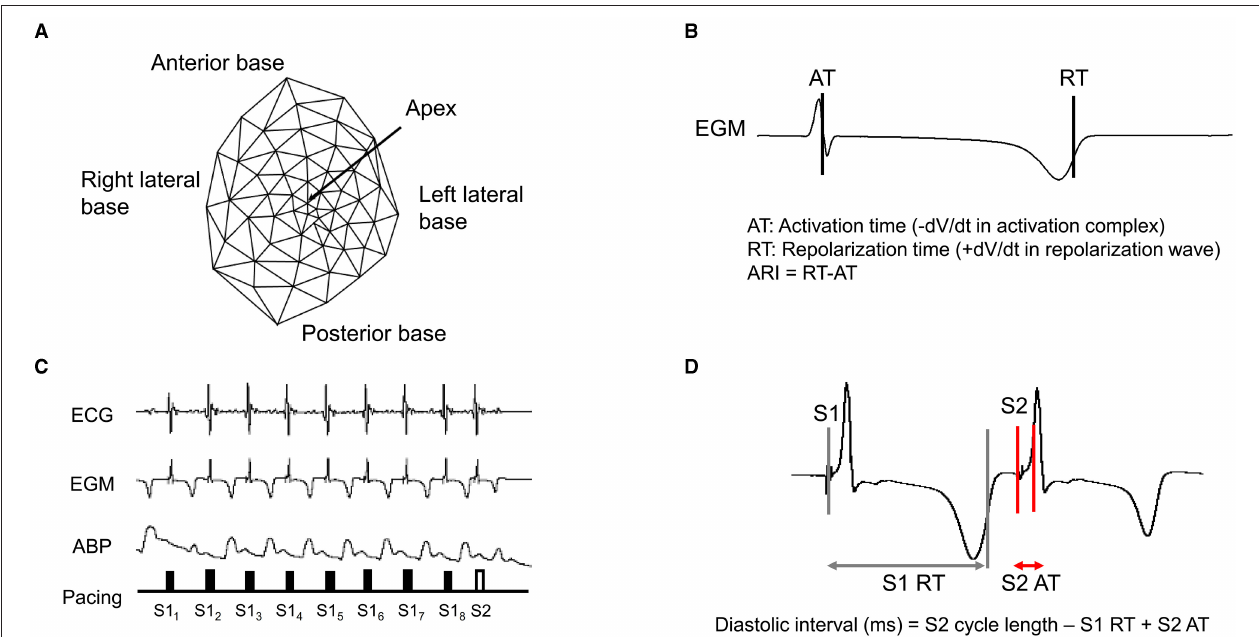
FIGURE 2 | Epicardial electrodes and representative example of S1/S2 pacing. (A) A 56-electrode high-fidelity epicardial sock array was placed around the heart to measure ventricular epicardial electrograms, (B) Activation recovery interval (ARI), (C) Representative example of electrocardiogram (ECG), electrogram (EGM), and arterial blood pressure (ABP) during S1/S2 pacing, (D) Diastolic interval. RT, repolarization time; AT, activation